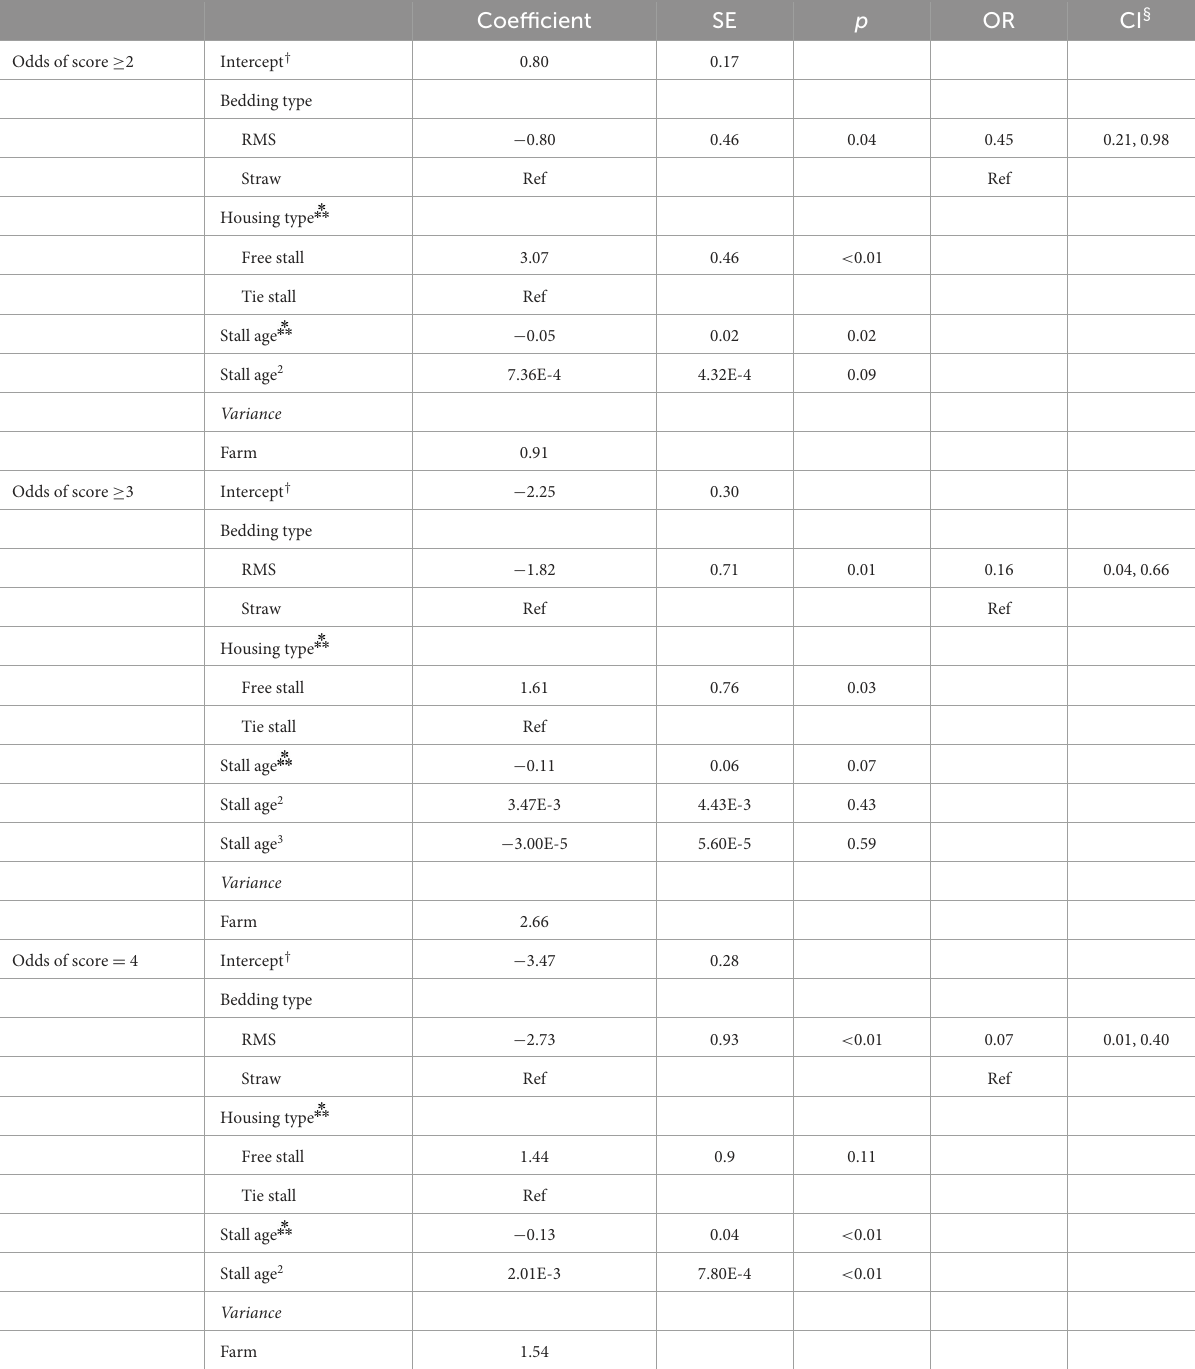
TABLE 4 Lower legs hygiene odds ratio comparing cows housed on recycled manure solids bedding to straw-bedded cows, and estimated using continuation-ratio mixed model. Coefficient SE p OR CI